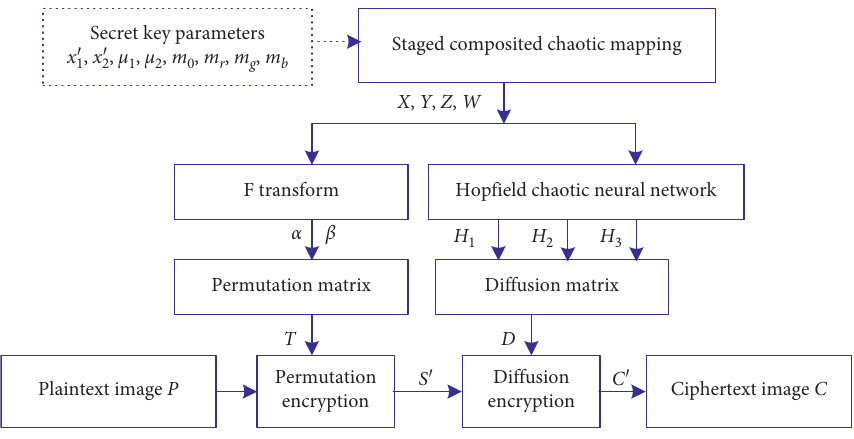
Figure 1: Block diagram of